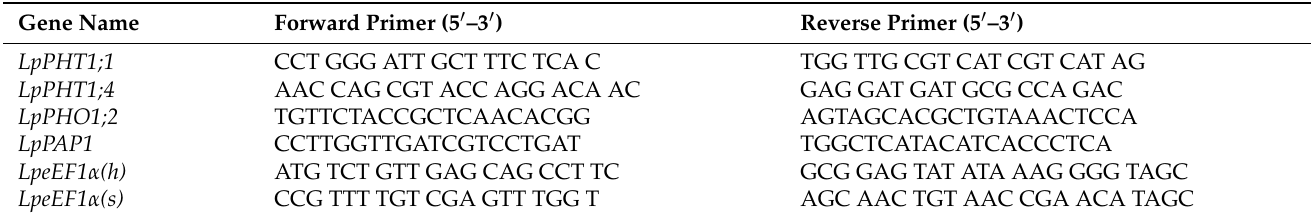
Table 2. Primer sequences used for relative expression analysis of phosphate transporter and purple acid phosphatase genes from